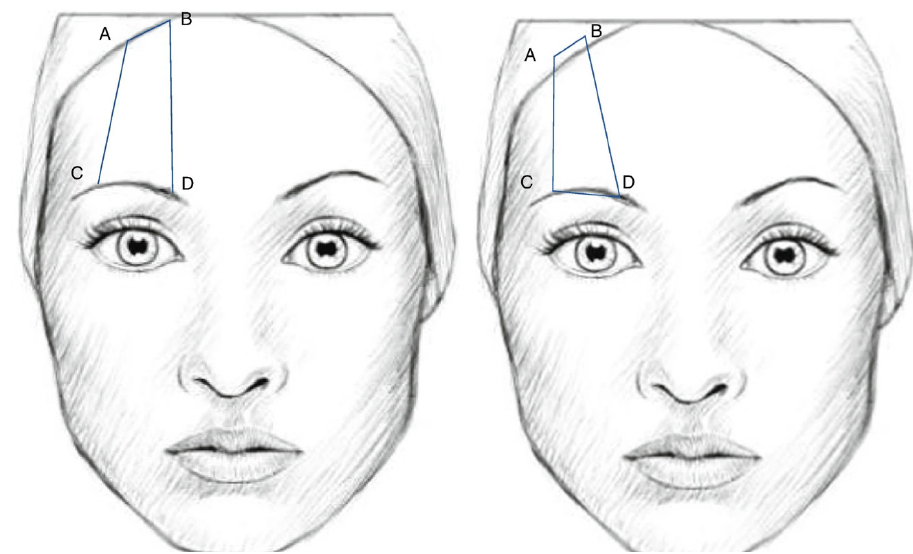
Figure 20. The use two-needle thread in N Shape (left) and O shape (right). For the N shape, (C,D) denote the entry and exit point respectively. (A,B) denote the anchoring points. For the (O) shape, (D) denotes both the entry and exit point. (A–C) denote the anchoring points. Reprinted with permission from Ref. [116].